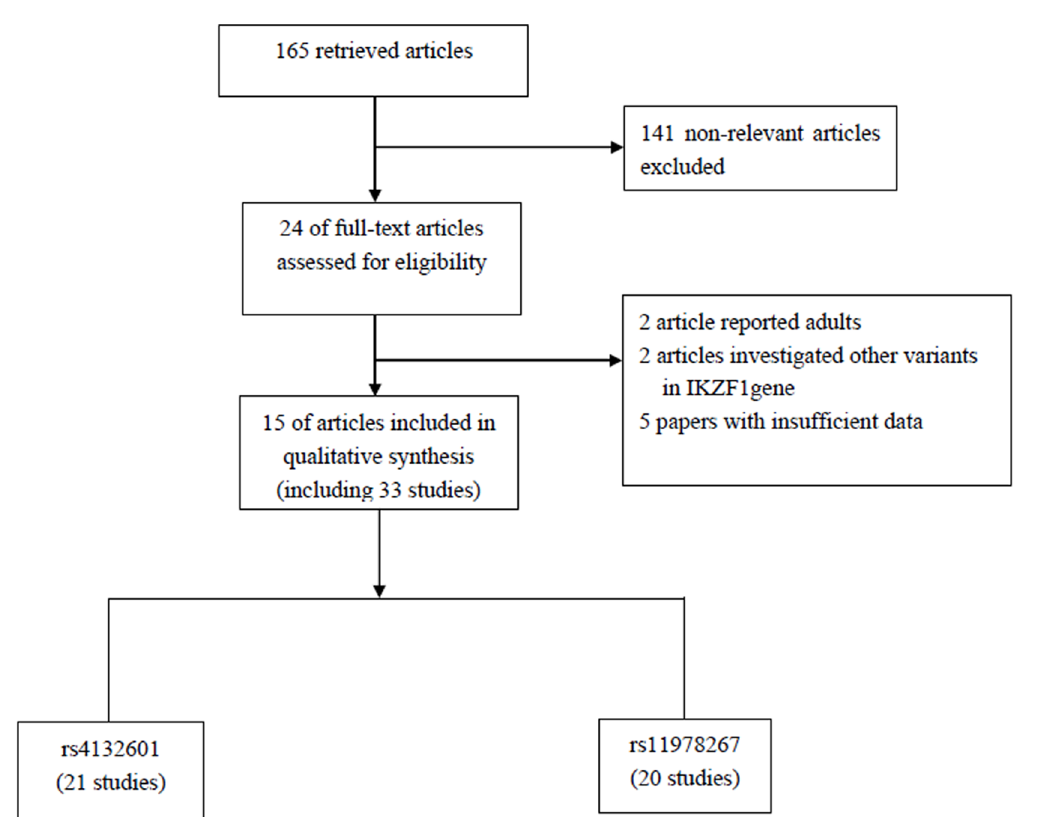
Figure 1. Flow diagram of study selection